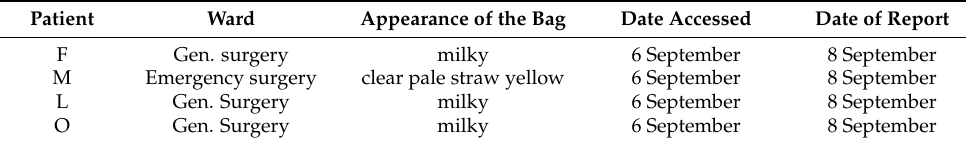
Table 4 summarize the most relevant data for each